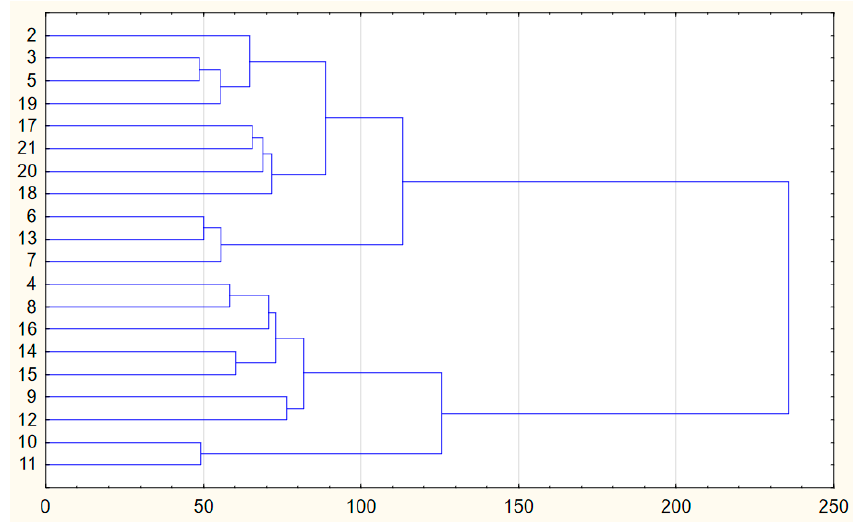
Figure 4. Cluster analysis dendrogram (own research). These numbers: 2—consumption needs to be reduced due to finite raw material resources; 3—the increasing demand for energy can be met by developing the use of renewable energy sources; 4—nuclear power is emission-free; 5—reducing CO 2 emissions is necessary to halt climate change; 6—I think that Poland should have its own nuclear power plants; 7—building a nuclear power plant is an element of making Poland independent from Russian energy supplies; 8—Poland has significant fuel resources to power nuclear power plants; 9—Poland should aim to have nuclear weapons; 10—a nuclear power plant has a negative effect on food quality; 11—there is a high risk of nuclear power plant failures; 12—it is necessary to regulate the human population due to the spectre of overpopulation, hunger, and lack of new energy sources; 13—new technologies in nuclear energy are the future of humanity; 14—the availability of knowledge about nuclear energy is sufficient; 15—I am well versed in nuclear energy issues; 16—I support the construction of a nuclear power plant in my district; 17—I only buy as much